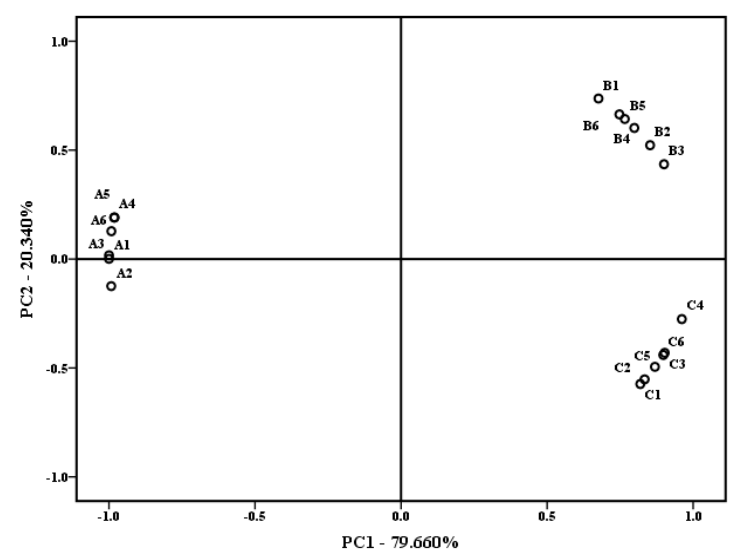
Figure 2. Principal component analysis (PCA) plot for electronic nose data of three kinds of skim milk samples. A, RSM; B, PSM; C, USM.